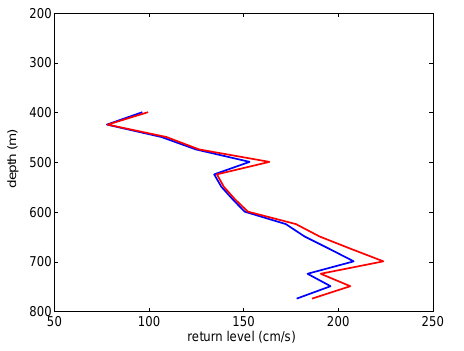
Fig. 11. 50 (red) and 250 (blue) years return level (cms − 1 obtained by fitting the GPD at different levels in sector 300/330 ◦ , at location FB.